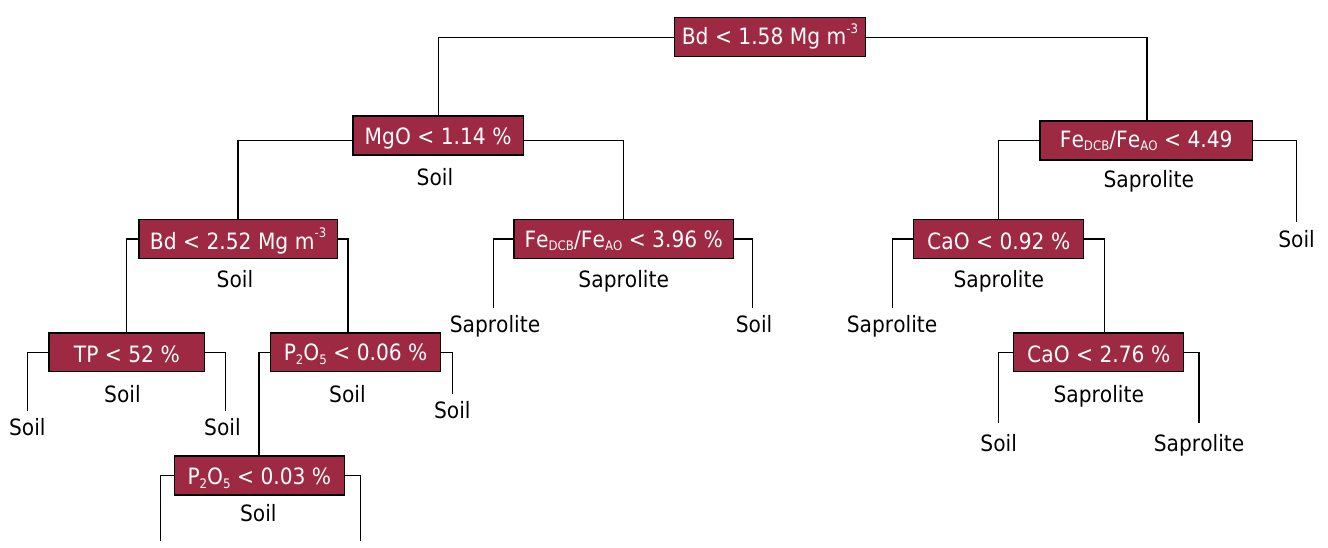
Figure 3. Decision tree scheme for the samples and cutting values of